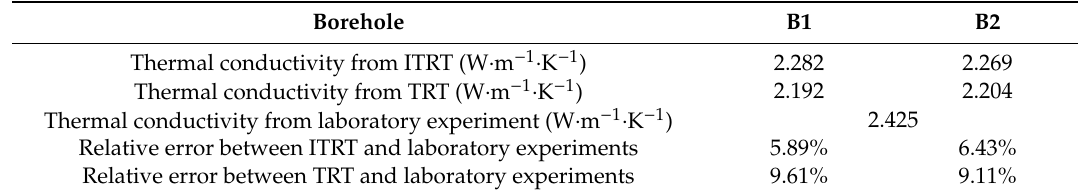
Table 4. Comparison of thermal conductivity.